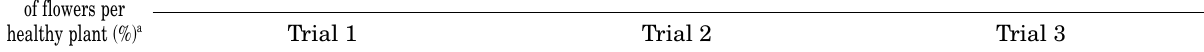
Table 4. The effect of selected strains of Fusarium , Trichoderma , oomycetes and bacteria applied by soil mixing (fungi) or root dipping (bacteria), on the number of flowers per healthy gerbera plant grown in open soilless systems (first and second trial, Albenga, 2000; third trial, Albenga, 2001). Increase in No.